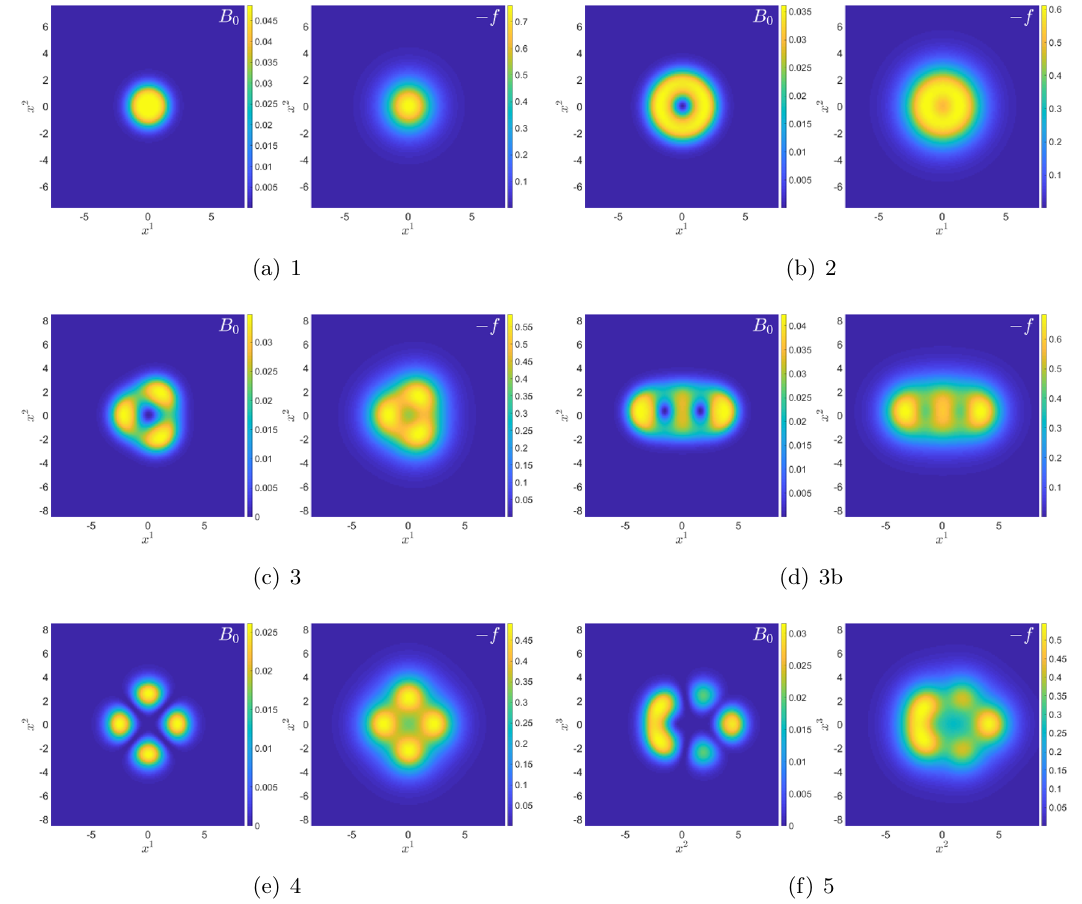
Figure 2 . Slices of baryon charge density B 0 (left) compared with the omega meson function f (right) for the Skyrmion solutions 1 through 5 of (cid:12)gure 1.